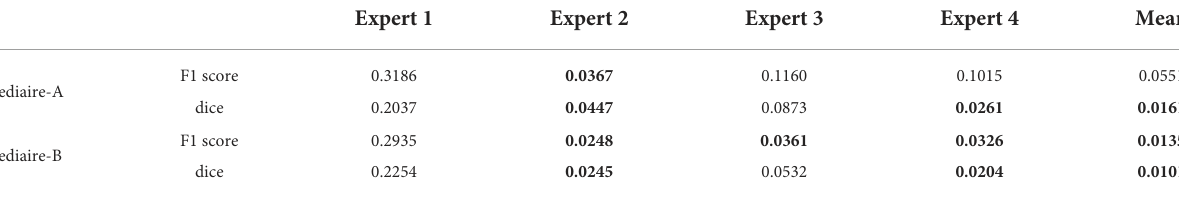
TABLE 2 p -values for testing non-inferiority of the performance of a pipeline (rows) compared to an expert (columns) with a margin of d = 0.05. Expert 1 Expert 2 Expert 3 Expert 4